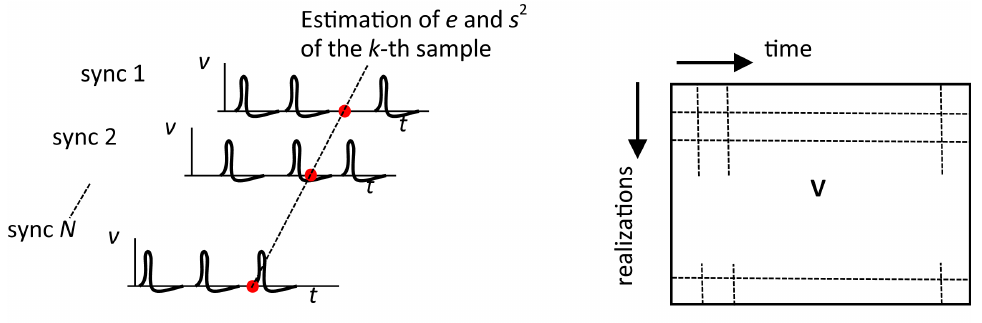
Figure 6. Multiple realizations of the process v ( t ) and the matrix of samples.